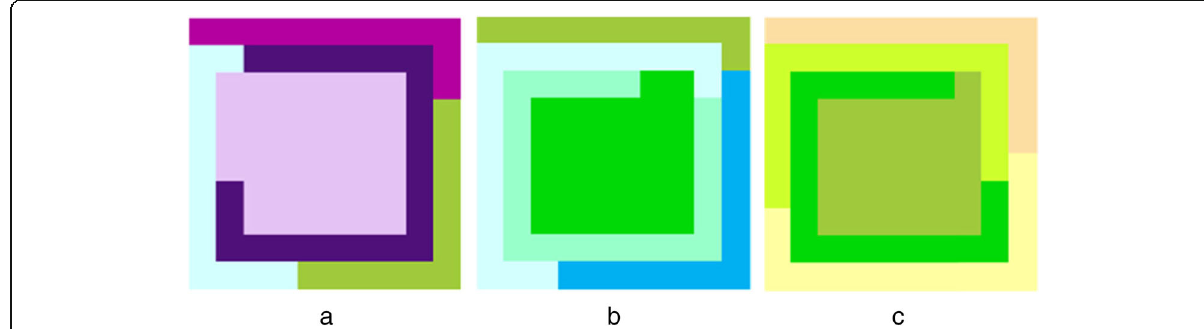
Fig. 2 Chromatic cards® generated for the study by Jacquot et al. (2016), each containing five distinct shades of colour: a lavender, b peppermint, and c cucumber; (see online version for colour image)